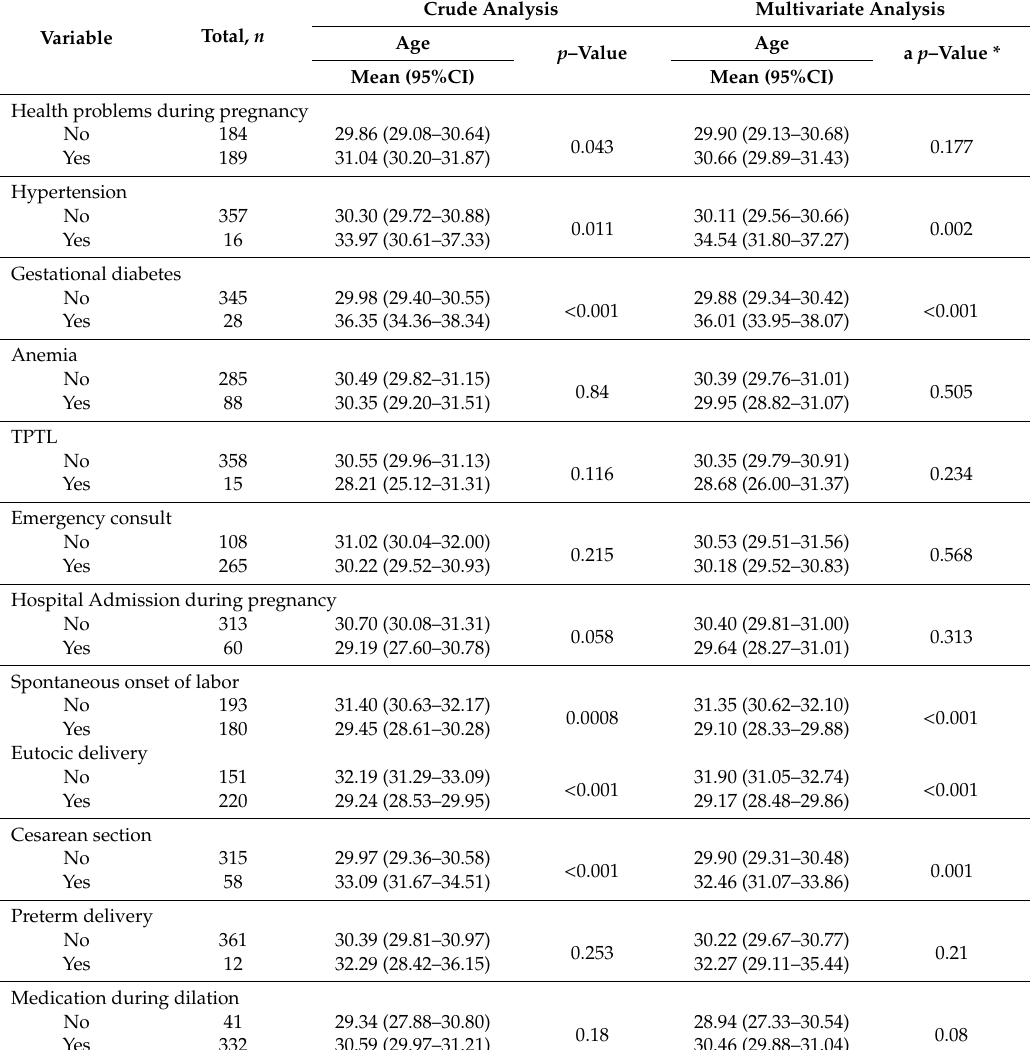
Table 2. Association between maternal age and di ff erent parameters during pregnancy, labor, delivery and the